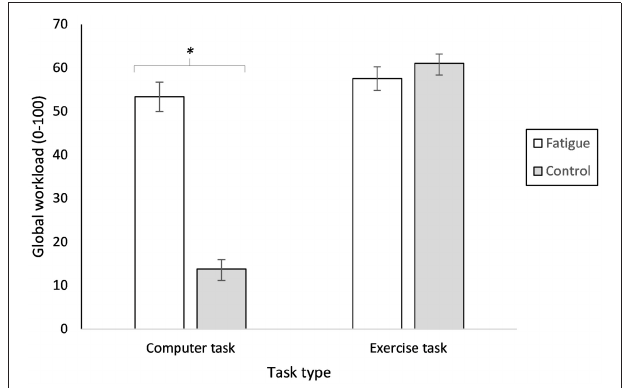
FIGURE 2 | Workload Measures. Global workload measures for computer and exercise tasks. *Significant interaction between task and intervention type ( p < 0.001). Data are presented as mean ± SEM.